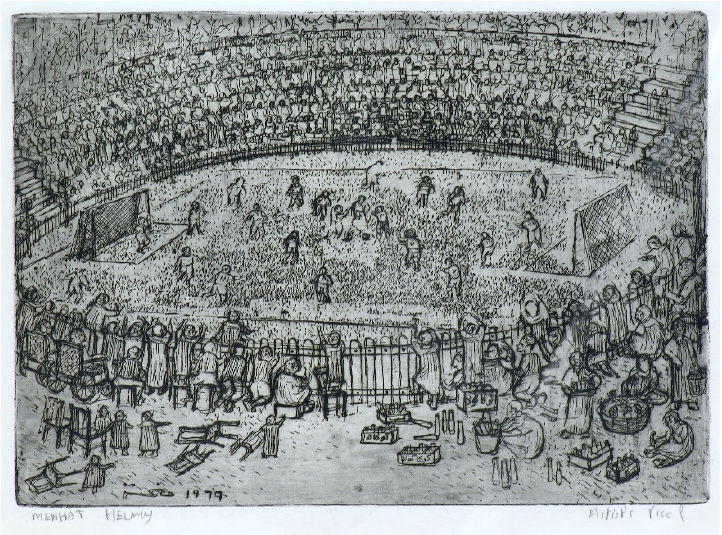
Figure 20. Menhat Helmy, Football Stadium (1966). Etching. Courtesy of estate of Menhat